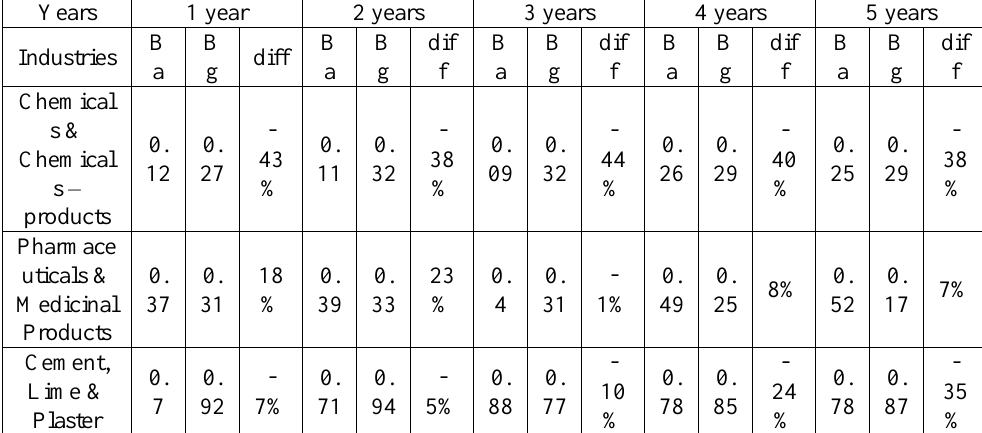
Table 2. Beta of Assets, Beta of Growth Opportunities and the difference between the 2 betas for all